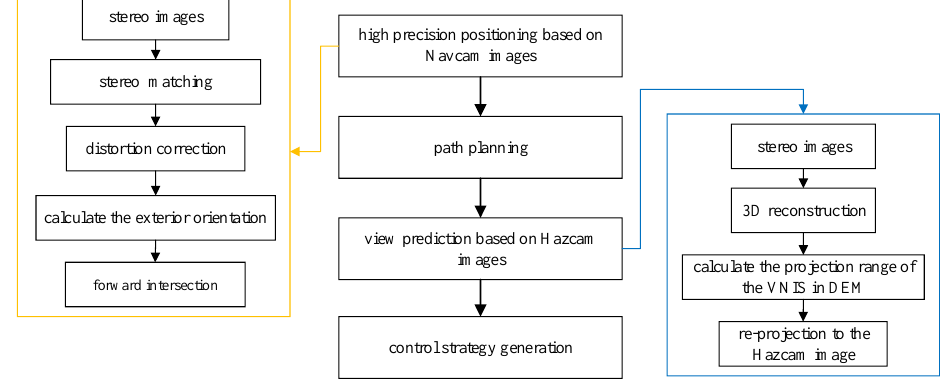
Figure 2. Flowchart of the successful